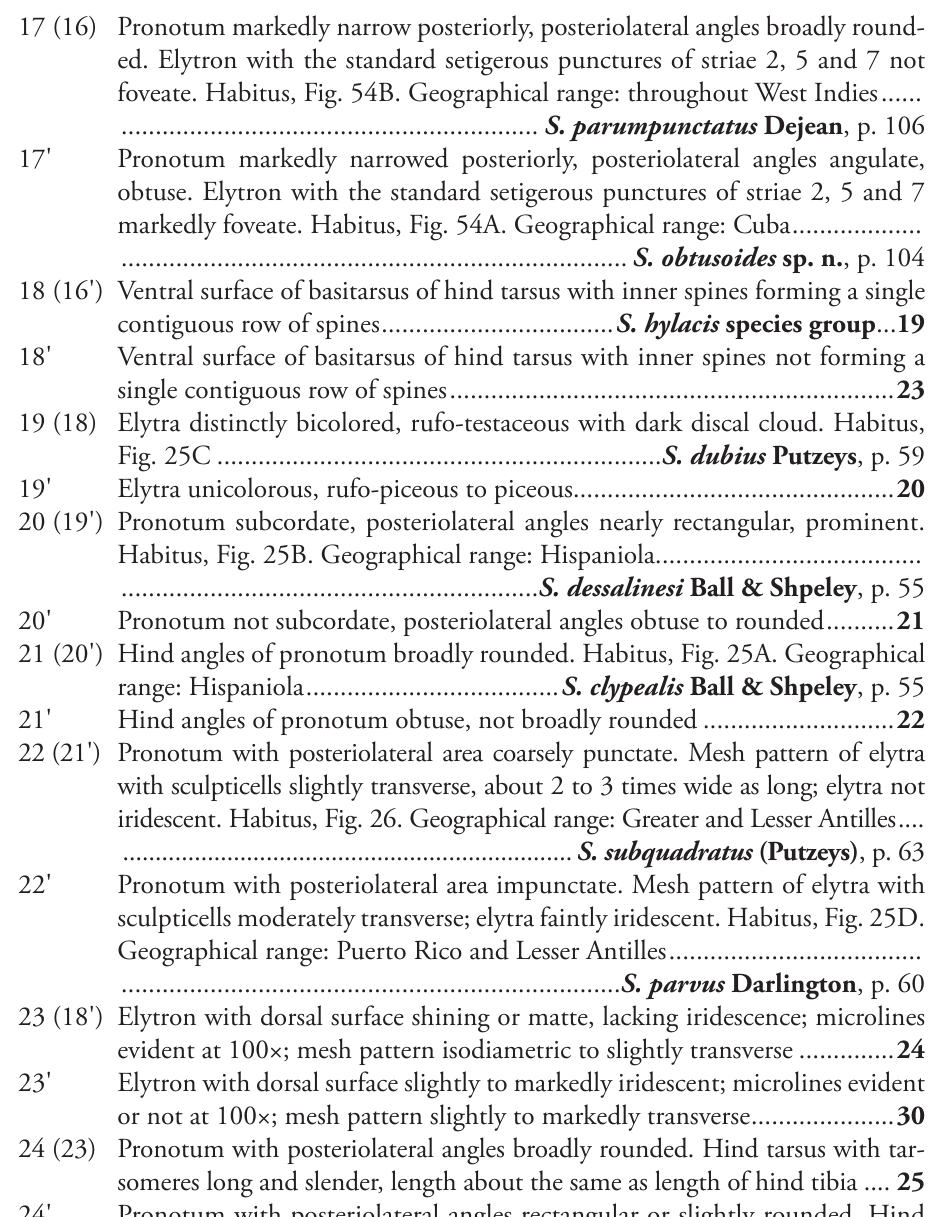
17 (16) Pronotum markedly narrow posteriorly, posteriolateral angles broadly round- ed. Elytron with the standard setigerous punctures of striae 2, 5 and 7 not foveate. Habitus, Fig. 54B. Geographical range: throughout West Indies ...... 17' Pronotum markedly narrowed posteriorly, posteriolateral angles angulate, obtuse. Elytron with the standard setigerous punctures of striae 2, 5 and 7 markedly foveate. Habitus, Fig. 54A. Geographical range: Cuba ................... 18 (16') Ventral surface of basitarsus of hind tarsus with inner spines forming a single 18' Ventral surface of basitarsus of hind tarsus with inner spines not forming a single contiguous row of spines ................................................................. 23 19 (18) Elytra distinctly bicolored, rufo-testaceous with dark discal cloud. Habitus, Fig. 25C ................................................................. S. dubius Putzeys , p. 59 19' Elytra unicolorous, rufo-piceous to piceous............................................... 20 20 (19') Pronotum subcordate, posteriolateral angles nearly rectangular, prominent. Habitus, Fig. 25B. Geographical range: Hispaniola....................................... 20' Pronotum not subcordate, posteriolateral angles obtuse to rounded .......... 21 21 (20') Hind angles of pronotum broadly rounded. Habitus, Fig. 25A. Geographical range: Hispaniola ..................................... S. clypealis Ball & Shpeley , p. 55 21' Hind angles of pronotum obtuse, not broadly rounded ............................ 22 22 (21') Pronotum with posteriolateral area coarsely punctate. Mesh pattern of elytra with sculpticells slightly transverse, about 2 to 3 times wide as long; elytra not iridescent. Habitus, Fig. 26. Geographical range: Greater and Lesser Antilles .... 22' Pronotum with posteriolateral area impunctate. Mesh pattern of elytra with sculpticells moderately transverse; elytra faintly iridescent. Habitus, Fig. 25D. Geographical range: Puerto Rico and Lesser Antilles ..................................... 23 (18') Elytron with dorsal surface shining or matte, lacking iridescence; microlines evident at 100×; mesh pattern isodiametric to slightly transverse .............. 24 23' Elytron with dorsal surface slightly to markedly iridescent; microlines evident or not at 100×; mesh pattern slightly to markedly transverse ..................... 30 24 (23) Pronotum with posteriolateral angles broadly rounded. Hind tarsus with tar- someres long and slender, length about the same as length of hind tibia .... 25 24' Pronotum with posteriolateral angles rectangular or slightly rounded. Hind tarsus with tarsomeres short, length about 2/3 length of hind tibia ............... 25 (24) Pronotum wider, posteriolateral impressions impunctate, or with only a few small punctures. Habitus, Fig. 22. Geographical range: Windward Islands of Lesser 25' Pronotum narrower, with posteriolateral impressions and adjoining areas moderately to densely punctate ........... S. discopunctatus species group ...